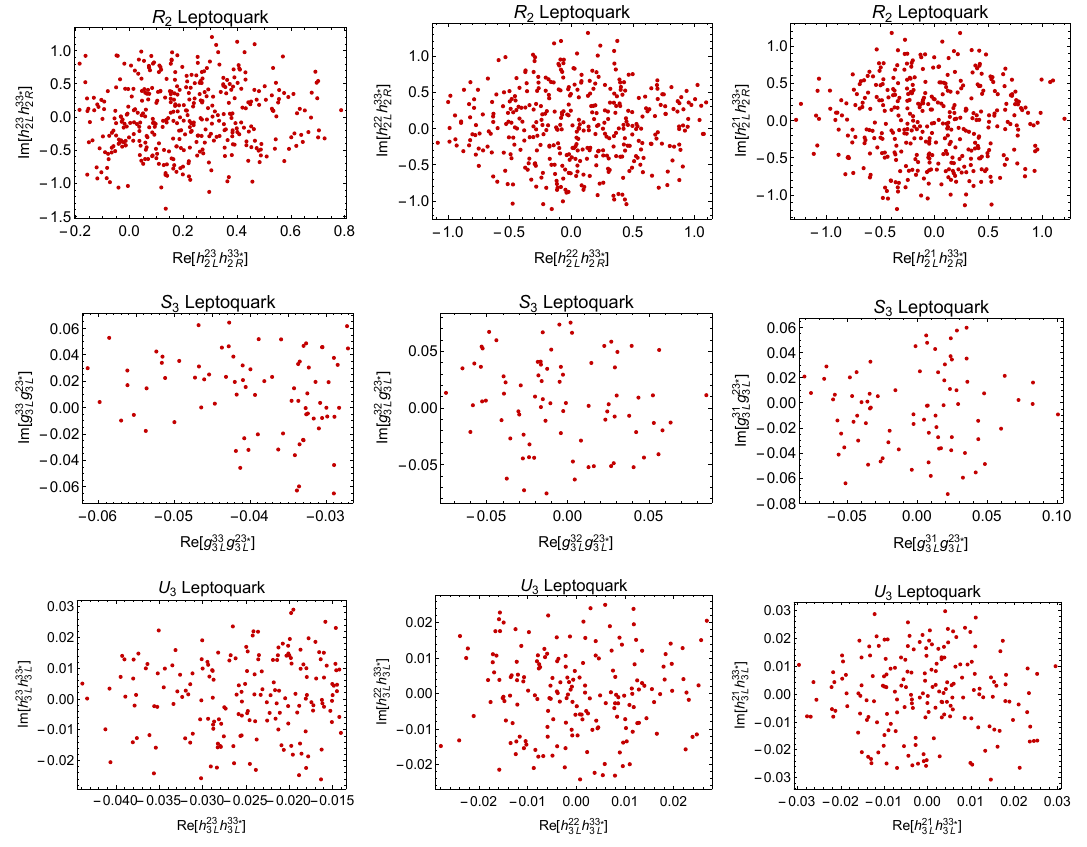
Figure 10 . Allowed regions for the couplings of the R 2 , S 3 , and U 3 leptoquark models in the case that all relevant couplings in each model are included simultaneously. We require that the couplings reproduce the measurements of R Ratio and R Ratio in eqs. (1.7) and (1.8) within 3 σ , D D ∗ satisfy ( B c τ − ¯ ν τ ) 30%, and are consistent with the upper bounds on ( B K ( ∗ ) ν ¯ ν ) at B → ≤ B → 90% C.L (the latter is only relevant for the left-handed couplings in the S 3 and U 3 models). different NP operators. For instance, the forward-backward asymmetry A FB ( q 2 ) tends to be mostly above the SM value in the presence of right-handed ( g R ) or tensor ( g T ) couplings, but is lower than the SM value for most allowed values of the scalar ( g S ) coupling.